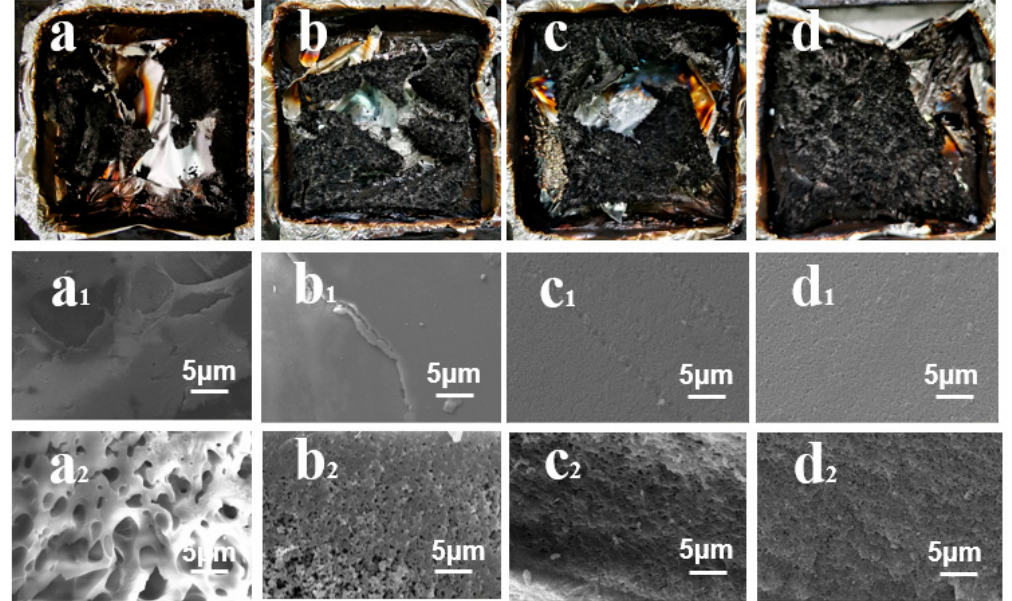
Figure 9. Digital photographs of the ( a – d ) residual chars and ( a 1 – d 1 ) SEM images of the residual char surfaces and ( a 2 – d 2 ) interior regions of ( a ) pure PBa; ( b ) PBa/DQ-1%; ( c ) PBa/DQ-3%; and ( d )PBa/DQ-5%.